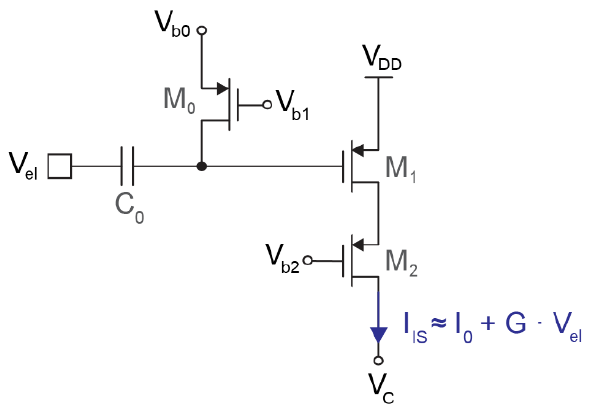
Figure 2. Schematic of the input stage, consisting of a high-pass filter (C 0 and M 0 ), a single PMOS transistor operating as transconductor (M 1 ), and a cascode (M 2 ).